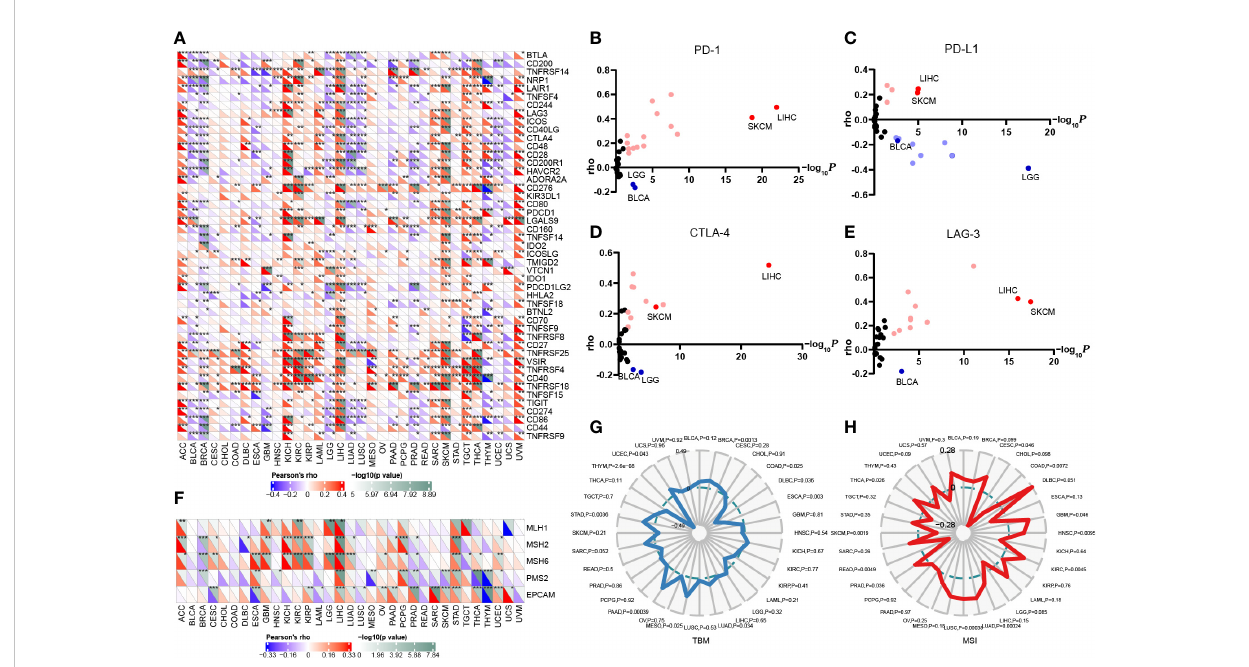
FIGURE 5 Correlation of FAM110A expression on immune checkpoints and immunotherapy. (A) The correlation of FAM110A with more than 40 immune checkpoint genes in pan-cancer (*P<0.05, **P<0.01, ***P<0.001). (B-E) The correlation of FAM110A with PD-1, PD-L1, CTLA-4 and LAG-3 in the TIMER 2.0 database. (F) The correlation of FAM110A with MMR-relate genes, including MLH1, MLH2, MLH6, PMS2 and EPCAM in pan-cancers (*P<0.05, **P<0.01, ***P<0.001). (G, H) The correlations of FAM110A expression and TMB, MSI in